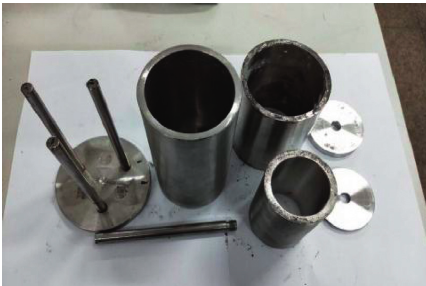
Figure 1: Pressing mold of hollow structure oxygen candle.